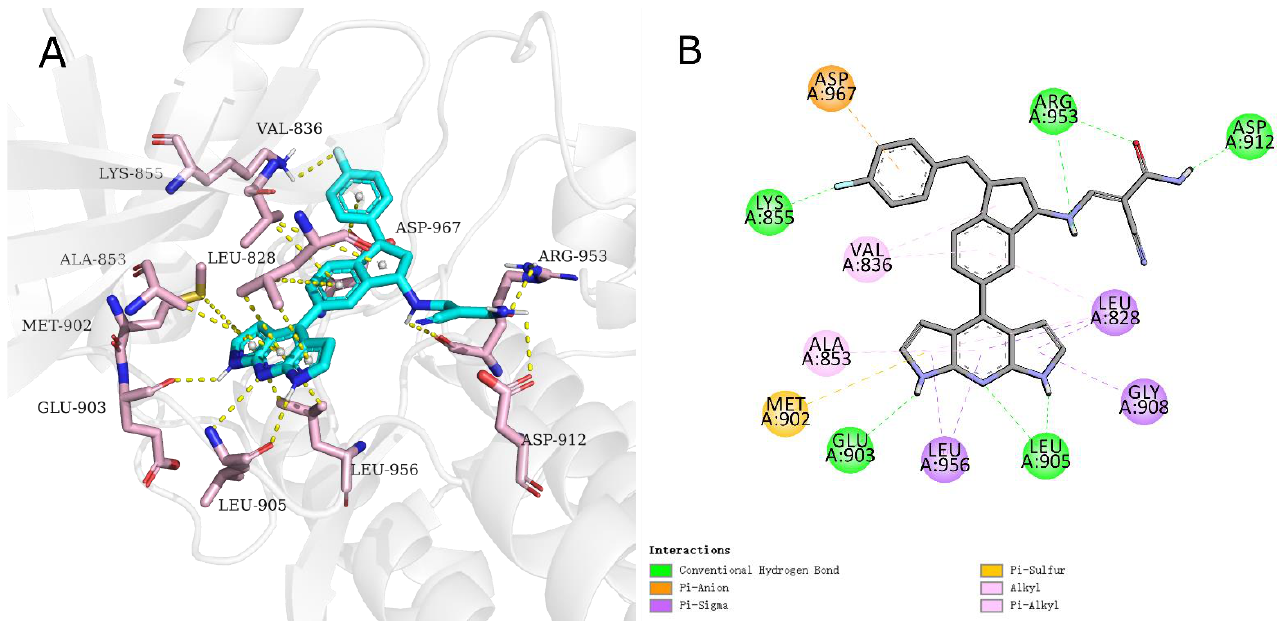
Figure 4. ( A ) Stereo view of the interaction of inhibitor 8 with residues near the active pocket of JAK3; ( B ) 2D map of the interaction of inhibitor 8 with key amino acids in JAK3.